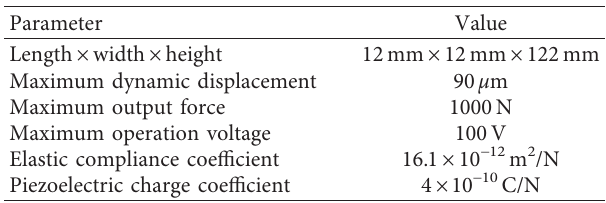
Figure 4: The dimension of the piezoelectric cantilever beam (unit: mm). Table 1: Parameters of piezoelectric stack.